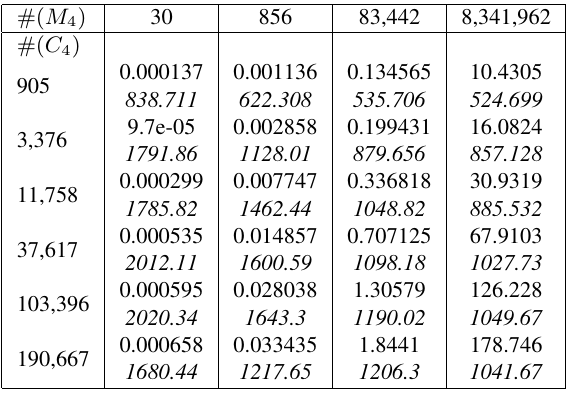
Table 2: The time (in seconds) for computing RWMEs between M 4 with varied sampling desities and C 4 with different filtering